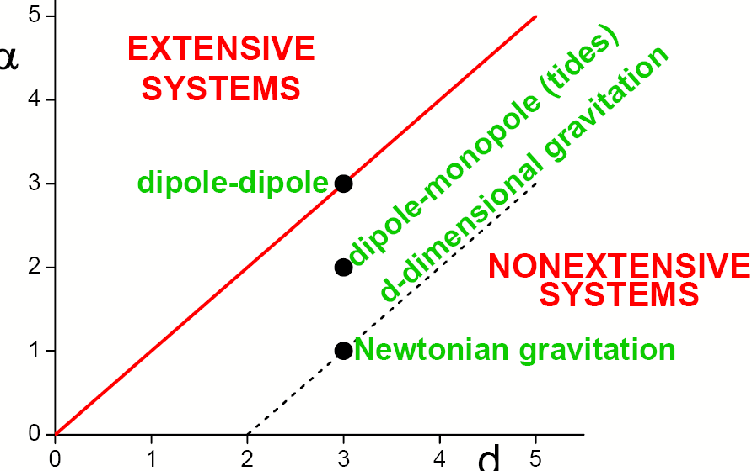
Figure 2. The so-called “extensive systems” ( α / d > 1 for the classical ones with the exponent α and dimension d ) correspond to an extensive total energy and typically involve absolutely convergent series, whereas the so-called “nonextensive systems” (0 ≤ α / d < 1 for the classical ones) correspond to a superextensive total energy and typically involve divergent series. The marginal systems ( α / d = 1 here) typically involve conditionally convergent series, which therefore depend on the boundary conditions, i.e., typically on the external shape of the system. Capacitors constitute a notorious example of the α / d = 1 case. The standard Lennard–Jones gas is located at ( d , α ) = ( 3,6 ) , thus belonging to the extensive class of systems. Taken from